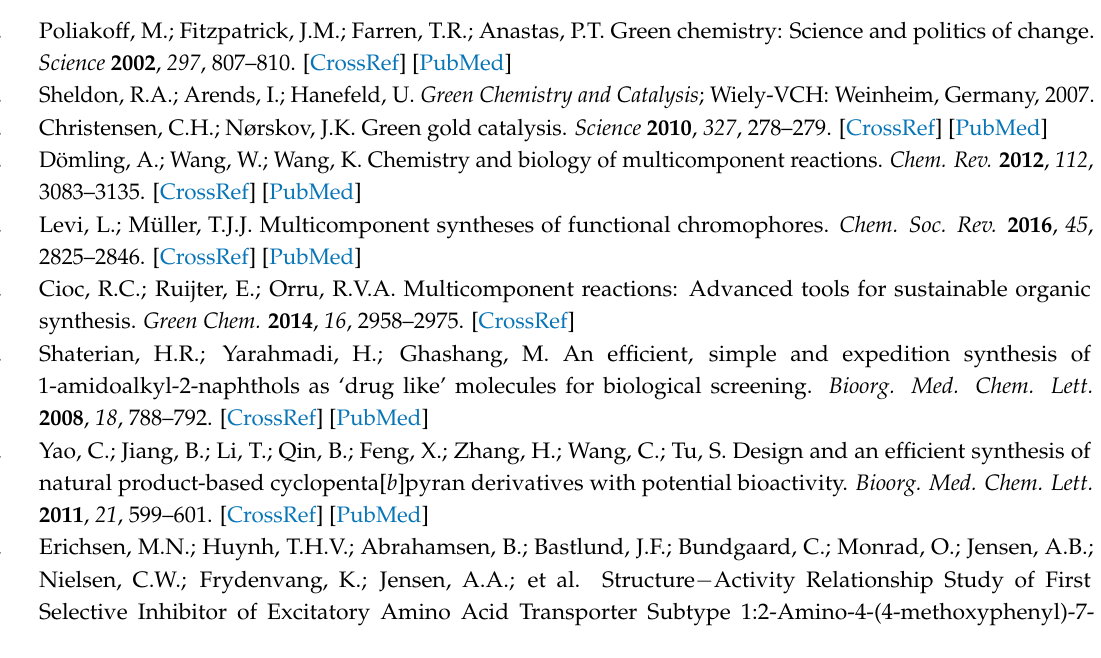
(Table 4, entry 8): White solid; M.p. ( ◦ C): 203–205; 1 H NMR (500 MHz, DMSO- d 6 ): δ 9.25 (s, 1H), 6.94–6.91 (m, 4H), 6.66 (d, J = 8.0 Hz, 2H), 4.07 (s, 1H), 2.49 (s, 2H), 2.24 (d, J = 16.0 Hz, 1H), 2.09 (d, J = 16.0 Hz, 1H), 1.03 (s, 3H), 0.95 (s, 3H). entry 13): White solid; M.p. ( ◦ C): 173–174; 1 H NMR (500 MHz, DMSO- d 6 ): δ 6.89 (s, 2H), 3.16 (t, J = 4.5 Hz, 1H), 2.44 (d, J = 17.5 Hz, 1H), 2.35 (d, J = 17.6 Hz, 1H), 2.28 (d, J = 16.0 Hz, 1H), 2.19 (d, J = 16.0 Hz, 1H), 1.48–1.44 (m, 1H), 1.37–1.30 (m, 1H), 1.13–1.19 (m, 2H), 1.03 (s, 3H), 1.00 (s, 3H), 0.84 (t, J = 7.5 Hz,